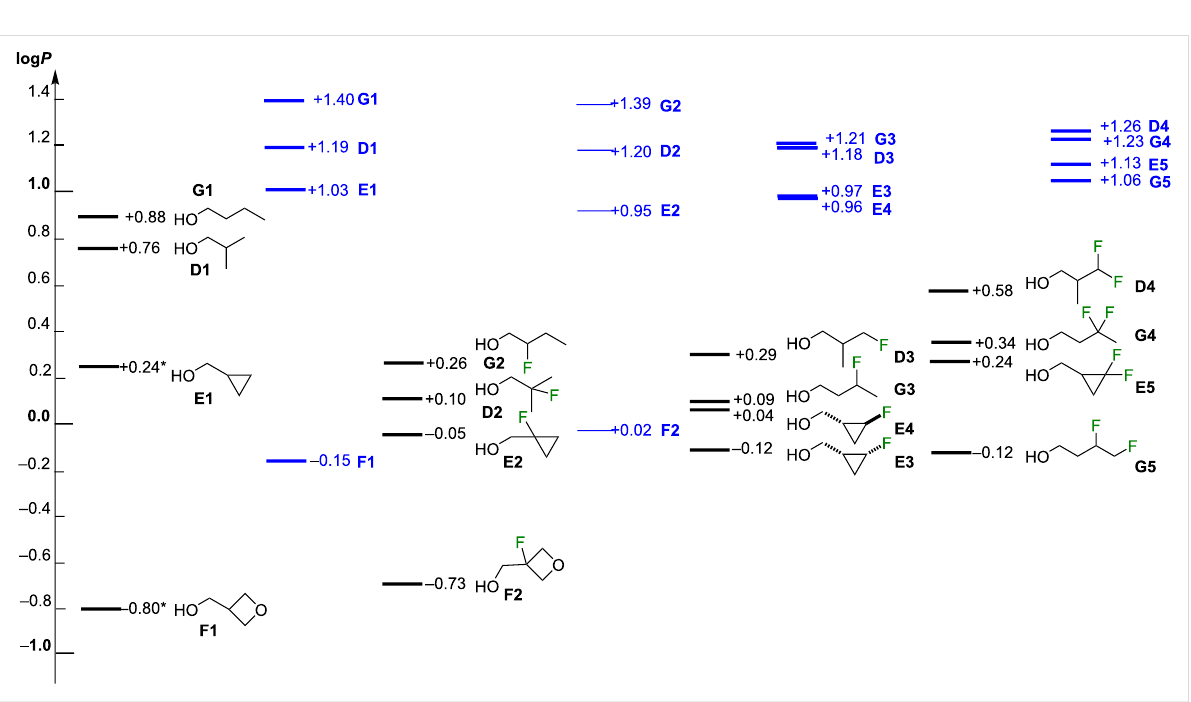
Figure 11: Experimental (in black) and theoretical (in blue) values (calculated at the MN15/aug-cc-pVTZ//MN15/cc-pVTZ level of theory) of all com- pounds, organized by motif.